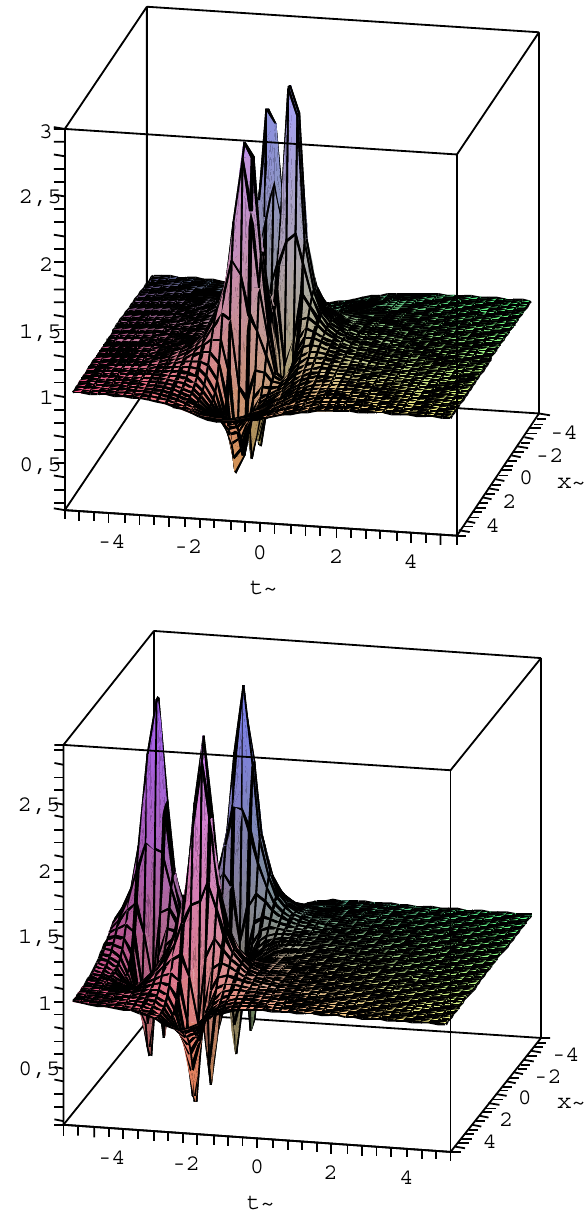
Fig. 2. Plot of | v(x,t) | for n = 2 with ϕ 1 = ϕ 2 = ϕ 3 = ϕ 4 = 0 at the top and ϕ 4 = 1 and ϕ 1 = ϕ 2 = ϕ 3 = 0 at the